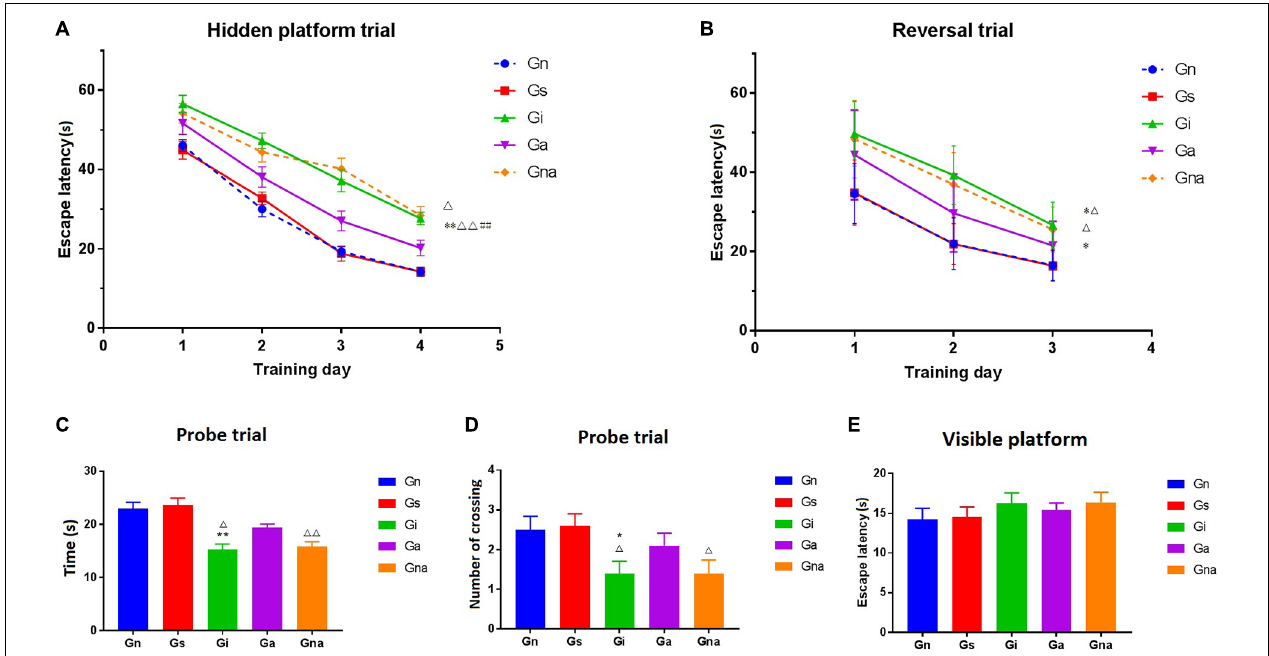
FIGURE 2 | Acupuncture improved the spatial learning and memory ability of VD mice in the Morris water maze. (A) Escape latency of each group in the hidden platform trial. (B) Escape latency of each group in the reversal trial. (C) Time spent in the former platform quadrant in the probe trial. (D) The number of crossing over the former platform location in the probe trial. (E) Escape latency of each group in the visible platform. The data are expressed as the mean ± SEM ( n = 10). * P < 0.05, ** P < 0.01, vs. Gn group; # P < 0.05, ## P < 0.01, vs. Gs group; (cid:77) P < 0.05, (cid:77)(cid:77) P < 0.01, vs. Ga group. Gn, normal group; Gs, sham-operated group; Gi, impaired group; Ga, acupoint group; Gna, non-acupoint